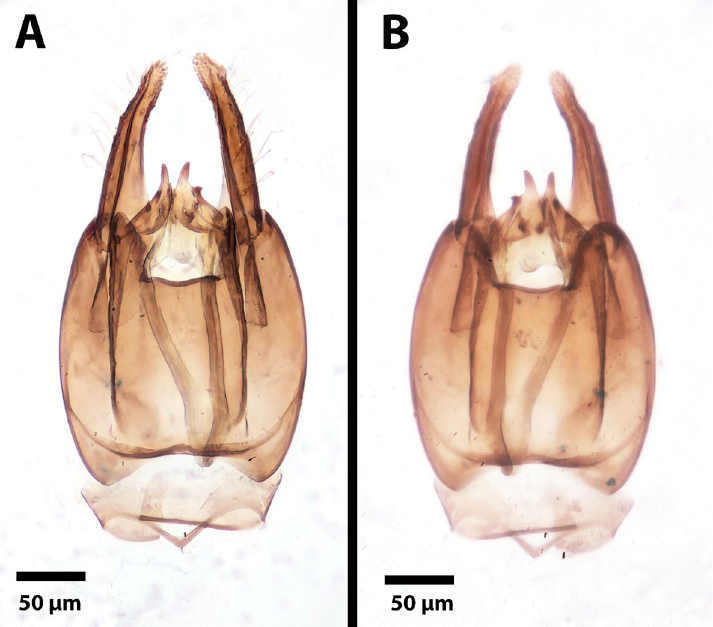
Fig. 29. The male genitalia for Dendrocerus serricornis (Boheman, 1832), from the slide preparation (prép. no. 7403/221) Dessart made in 1974 (MNhN EY22454). A . Ventral view. B . Dorsal